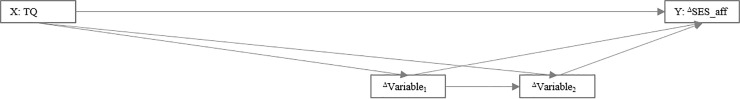
Model specification that investigates if the relationship between baseline tinnitus-related distress and change in affective pain perception is associated with change patterns in psychological process variables.